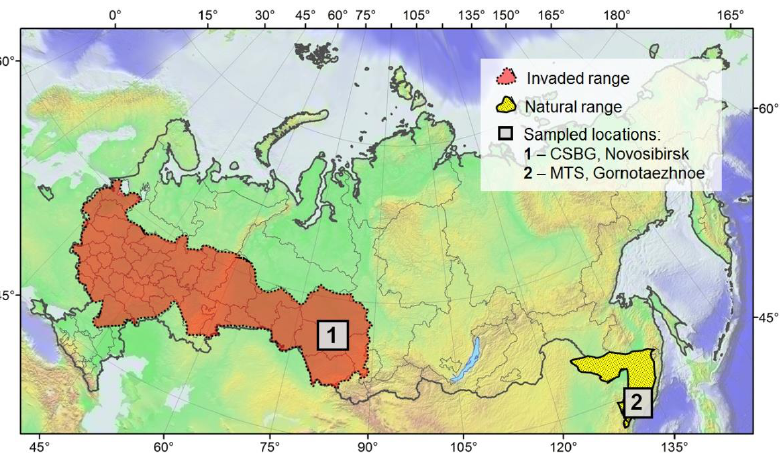
Figure 1. The studied localities in the Russian Far East and in western Siberia. MTS — the botanical garden of the Mountain-Taiga Station, Gornotaezhnoe, Ussuriysk District, Primorskiy Territory; CSBG — the Central Siberian Botanical Garden, Novosibirsk.